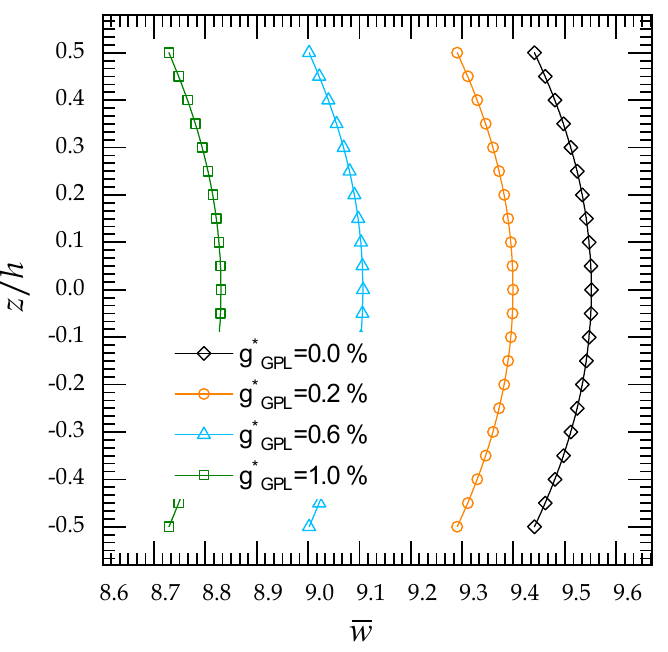
Figure 16. Dimensionless transverse displacement w of simply supported GRNC plate through the thickness of the UD GRNC plate for various weight fractions g ∗